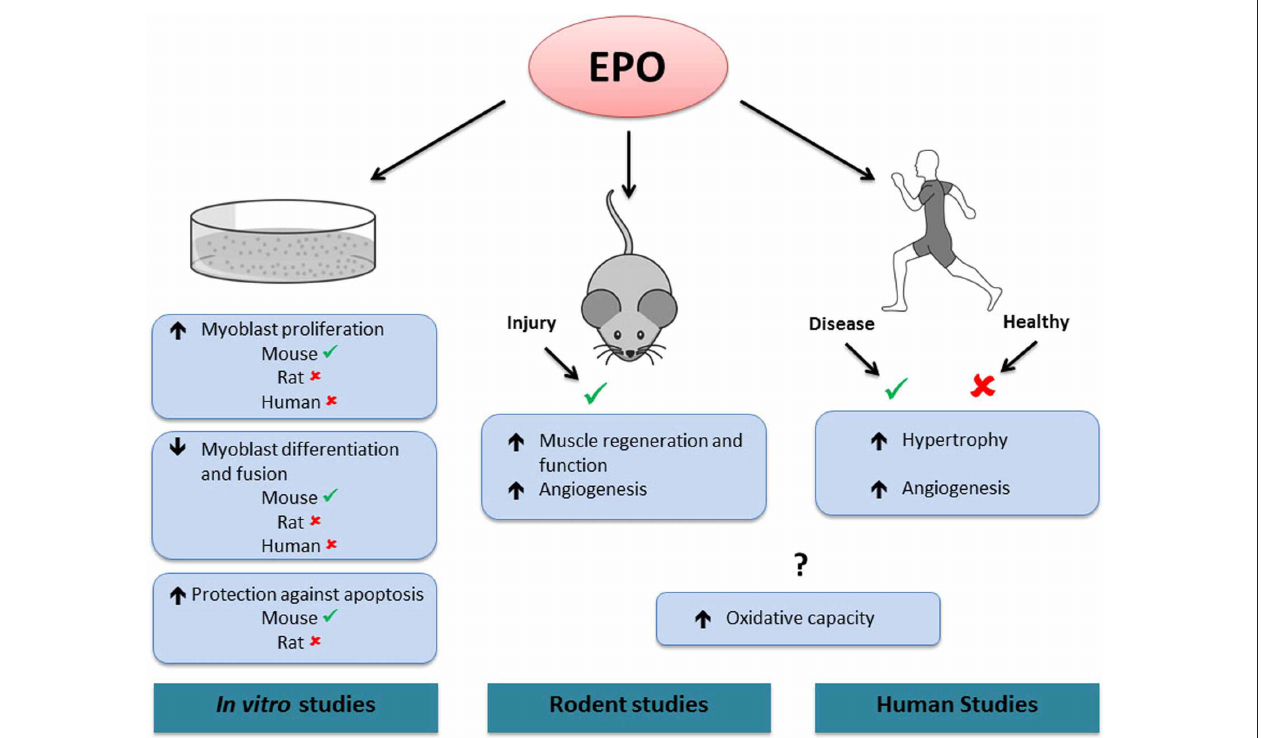
FIGURE 2 | Effects of EPO in skeletal muscle. (cid:2) , activated by EPO. ✘ , not activated by EPO. ?, contradictory results. In vitro, EPO treatment increases mouse, but not rat or human myoblast proliferation. EPO treatment decreases differentiation and fusion of mouse, but not rat or human myoblasts. EPO treatment protects against apoptosis in mouse but not in rat myoblasts. In rodents, EPO treatment increases muscle regeneration and angiogenesis following injury. In humans, EPO